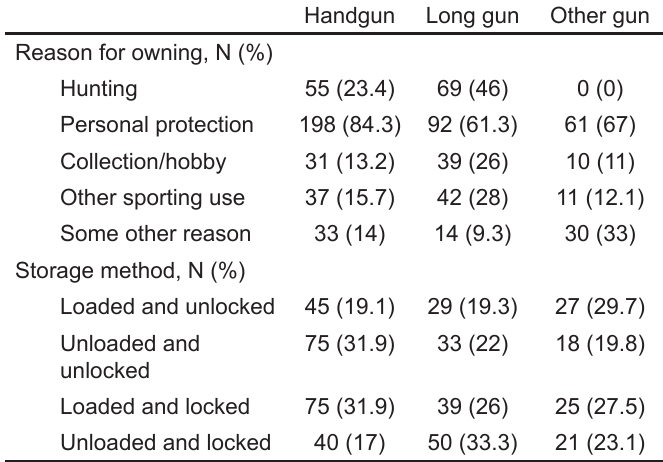
Table 6. Patient primary reason for gun ownership and gun storage